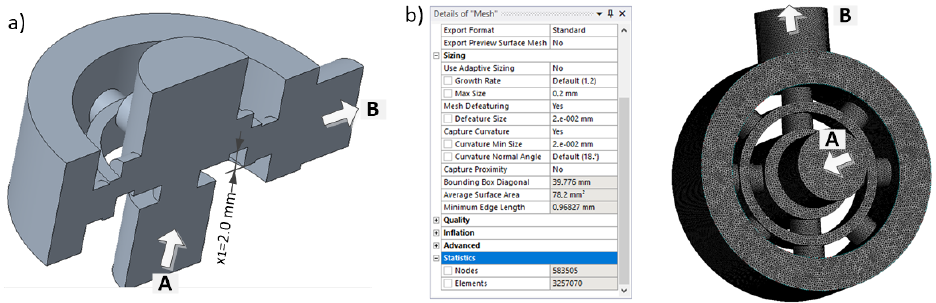
Figure 5. Flow control valve: ( a ) cross-sectional view of a geometric model, ( b ) case 3 of the meshed model.